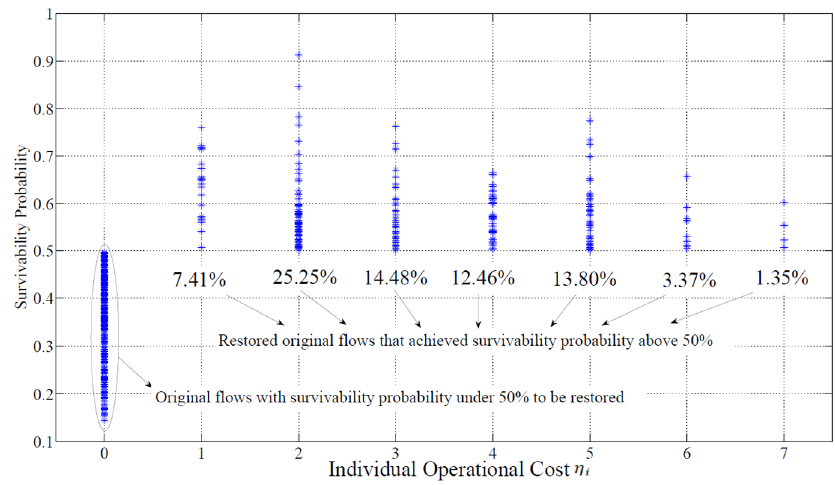
Figure 5. Individual Operational Cost Survivability Trade-off.